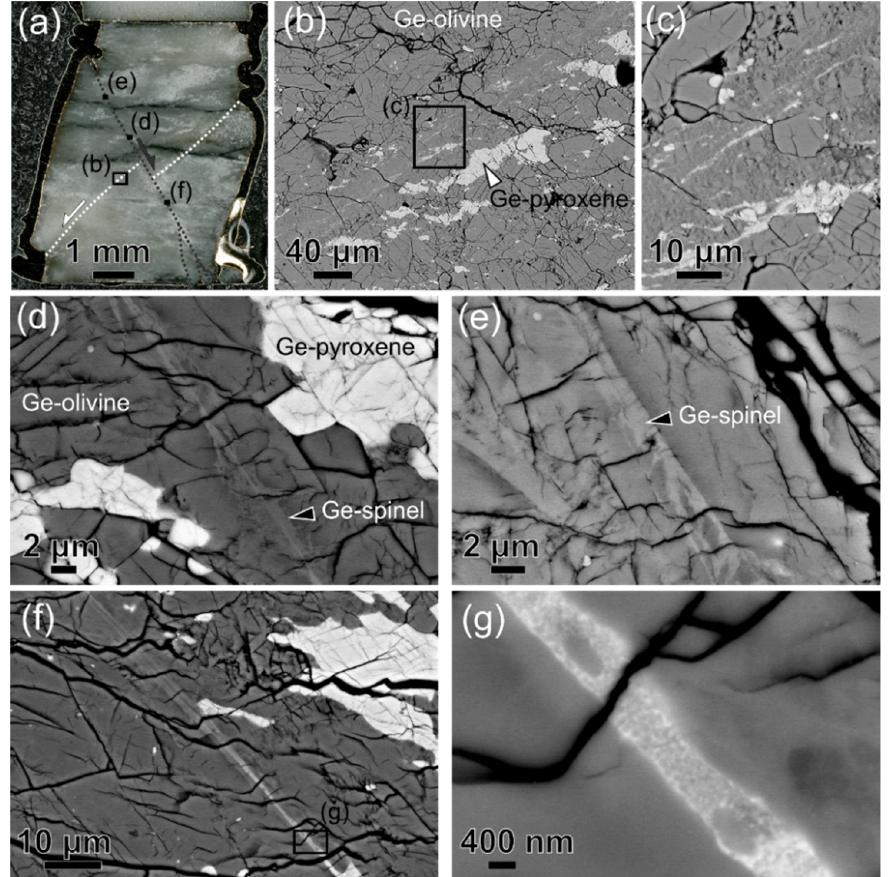
Figure 13. Optical and SEM images of sample G42. Compression direction is vertical on all images. ( a ) Optical image of the whole sample. The main faults are shown with the dashed lines. Slip direction is given by the half-headed arrows. ( b – g ) SEM images according to the rectangles labelled in ( a , b , f ). ( b ) Shows the first shear zone. Starting material texture is preserved on both sides and contrasts with the intense shearing of Ge-pyroxene within the shear band. ( c ) Close-up view according to the rectangle in ( b ). A breccia texture with heterogeneous grain size can be seen within the shear band. ( d , e ) are magnified views of the second fault that reveal a thin planar feature mostly filled with Ge-spinel. This latter phase is found in spearhead shapes that strongly resemble natural pseudotachylites. ( f ) Another location of the same fault where a Ge-pyroxene grain visible at the bottom of the image was sheared by the fault in a spectacular way, leaving a trail behind due to mixing with Ge-olivine. ( g ) Magnified view of the sheared Ge-pyroxene grain shown in ( f ) revealing a two-phase texture with rounded grains <100 nm in diameter.